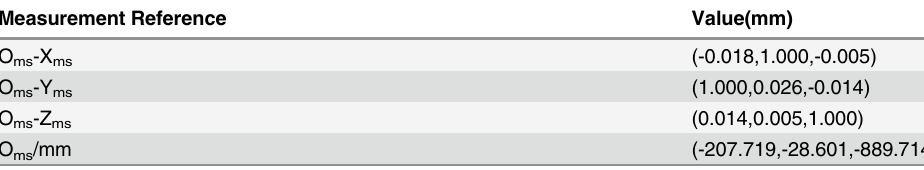
Table 3. The parameters of measurement reference.